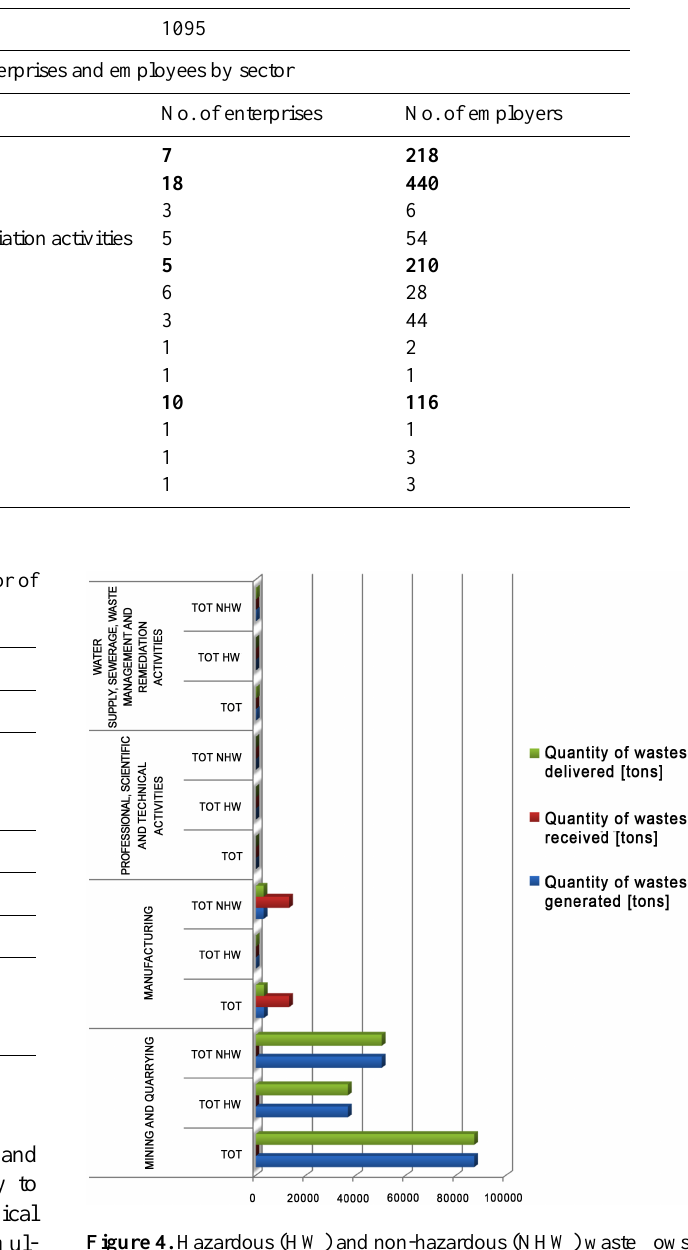
Figure 4. Hazardous (HW) and non-hazardous (NHW) waste flows by sector. Source: